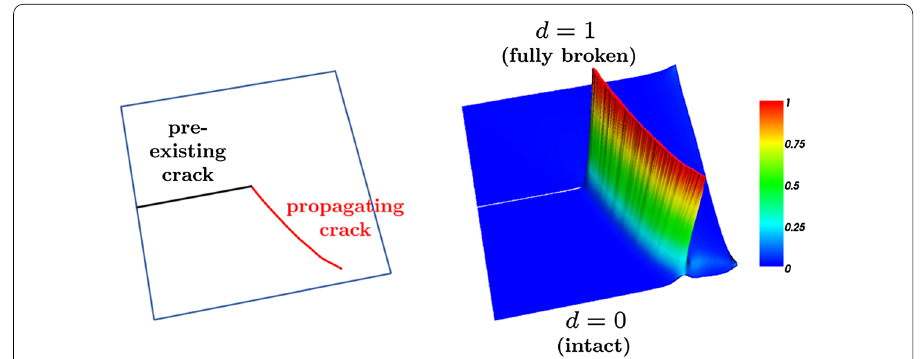
Fig. 1 Phase-field description of fracture (sketchy): d ∈ C ( (cid:3) , [0 , 1]) is the crack